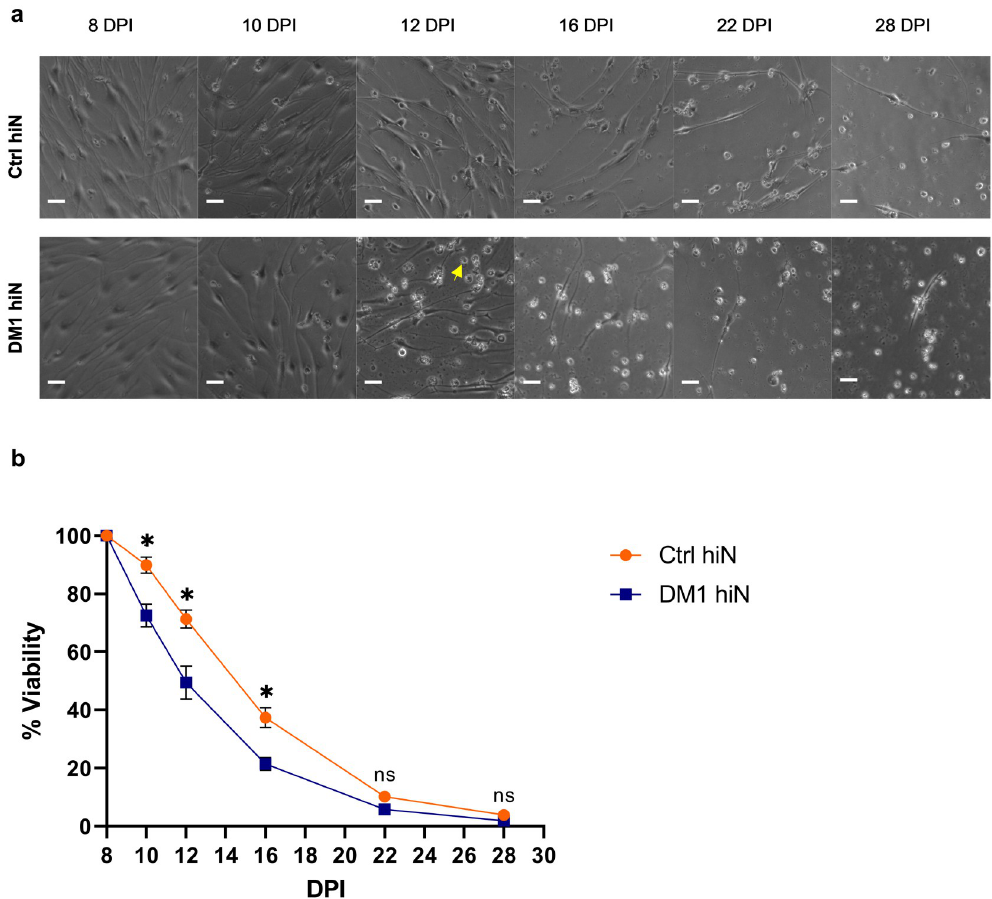
Fig 2. Reduced viability of DM1 hiNeurons. (a) Representative live images demonstrate viability of control and DM1 hiNeurons at the indicated intervals. DM1 hiNeurons (bottom panel) show rapid reduction of cell viability from as early as 10 DPI followed by progressive loss. Arrow indicates dead neurons. Scale bar, 50 μ m. (b) Graph shows comparison between the viability of control and DM1 hiNeurons over 4 weeks period relative to their baseline count at 8 DPI (15,773 cells per ctrl group and 24,565cells per DM1 group were counted at baseline). About 50% of DM1 hiNeurons were viable by 12 DPI. Adherent cells were counted manually at the indicated intervals using ImageJ software. Data are presented as mean ± SEM. n = 3 for each group, a total of 90 images were analyzed per group. � P < 0.05 and ns, not significant compared to control group by unpaired